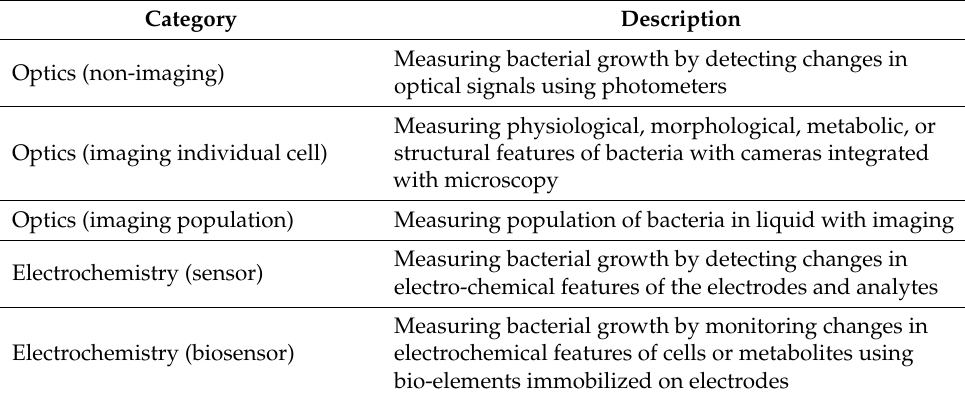
Table 3. Summary of online biosensors for detection of E. coli